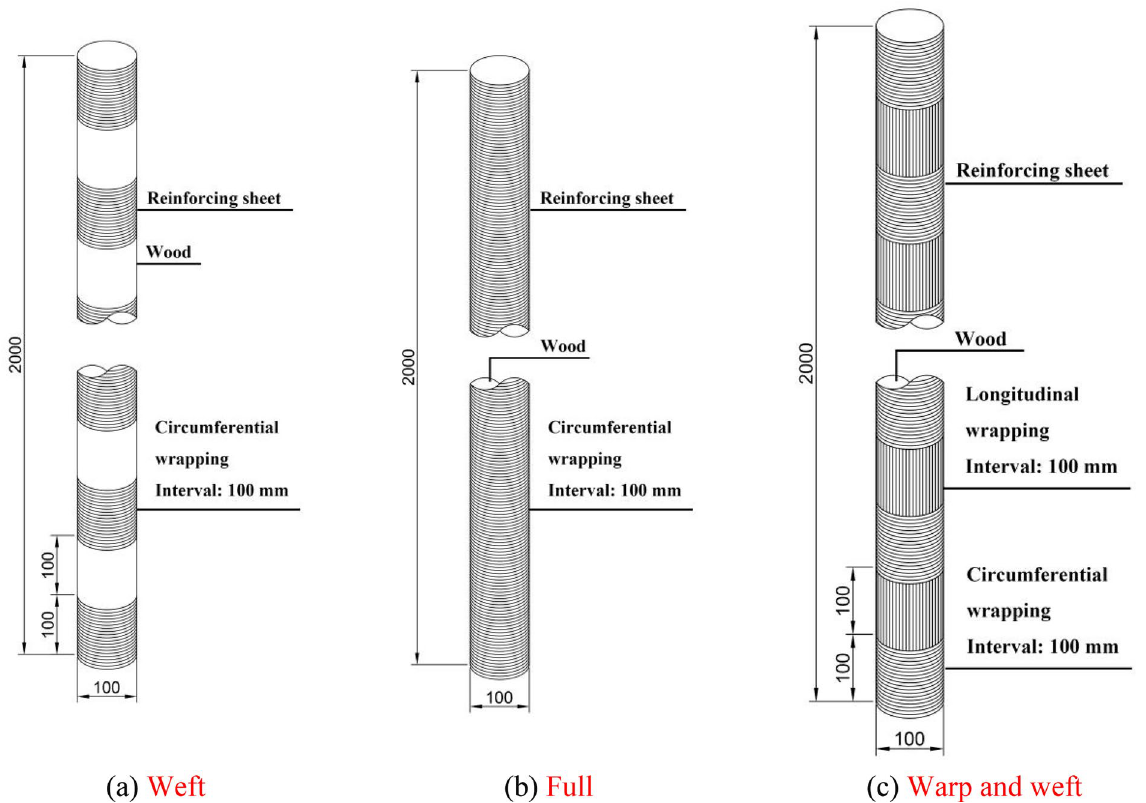
Fig. 8 The schematic diagram of adhesion